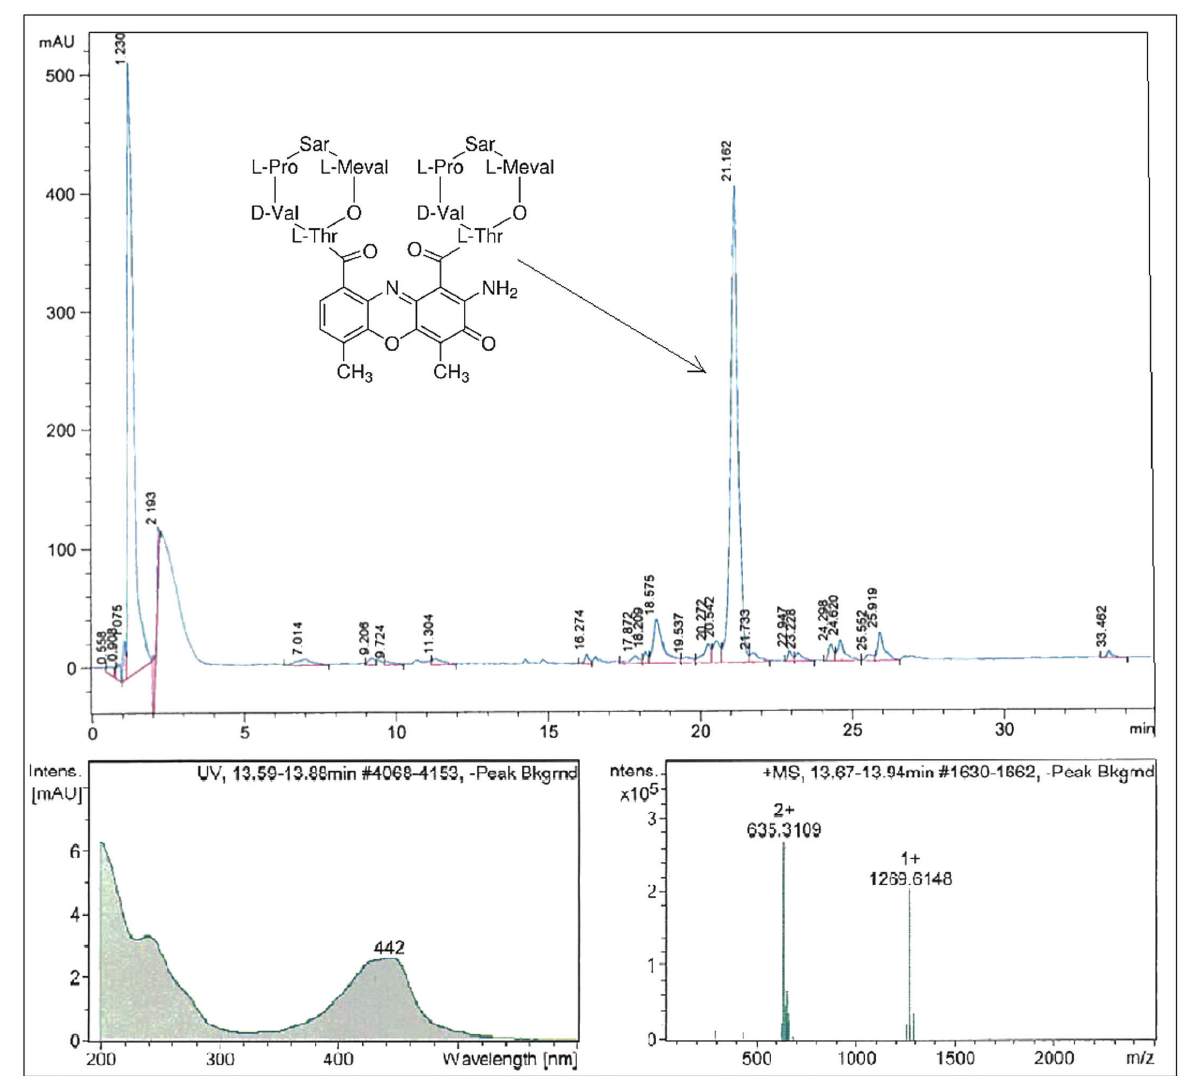
FIGURE 3 - Fractionation RP-HPLC chromatogram of detected antibiotic actinomycin D with UV spectrum and prominent ion